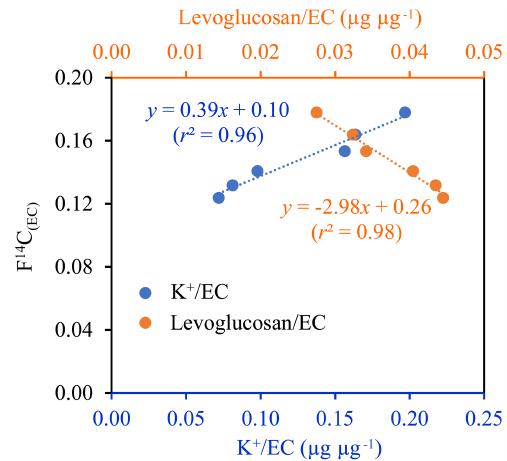
Figure 3. Correlation between F 14 C ( EC ) and K + / EC ratios and levoglucosan / EC ratios in summer. Data in other seasons are pre- sented in Fig.